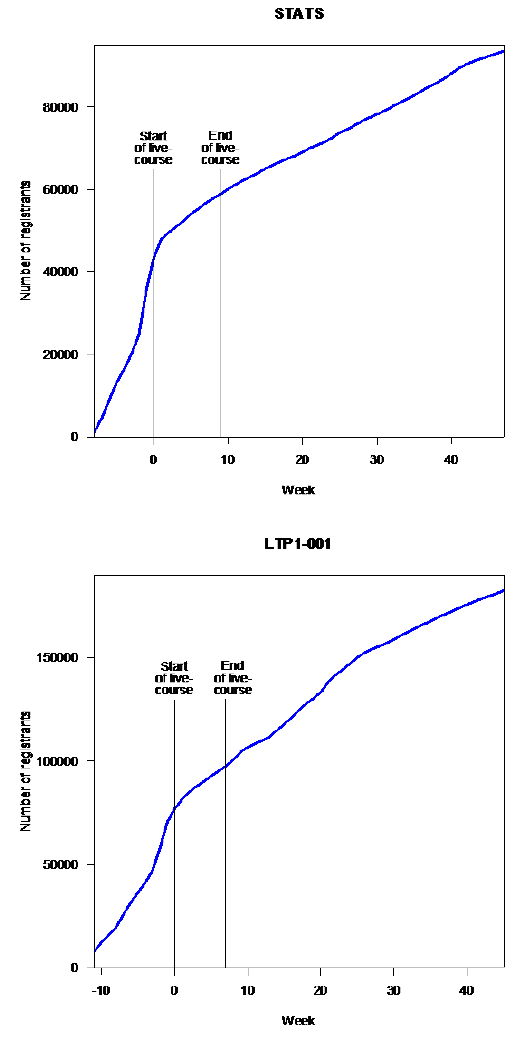
Figure 1. Registration in STATS and LTP1